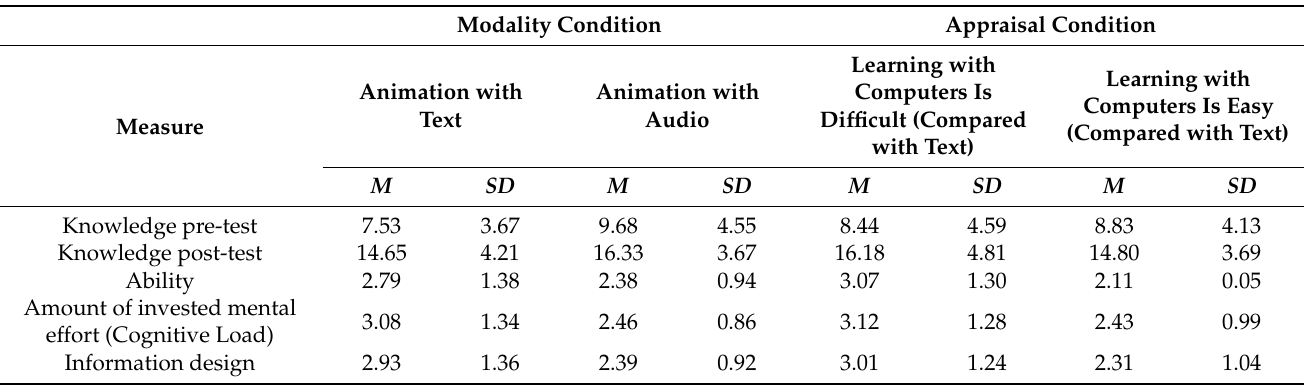
Table 4. Descriptive data of study 2 in group